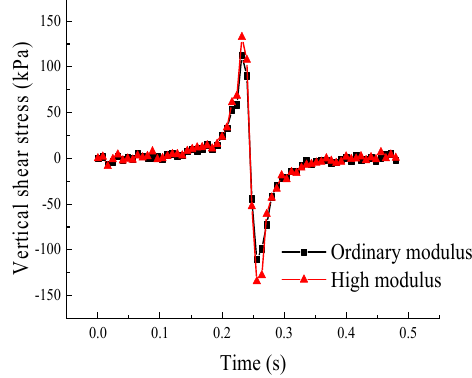
Figure 6. Comparison of vertical shear stress in the middle surface layer.